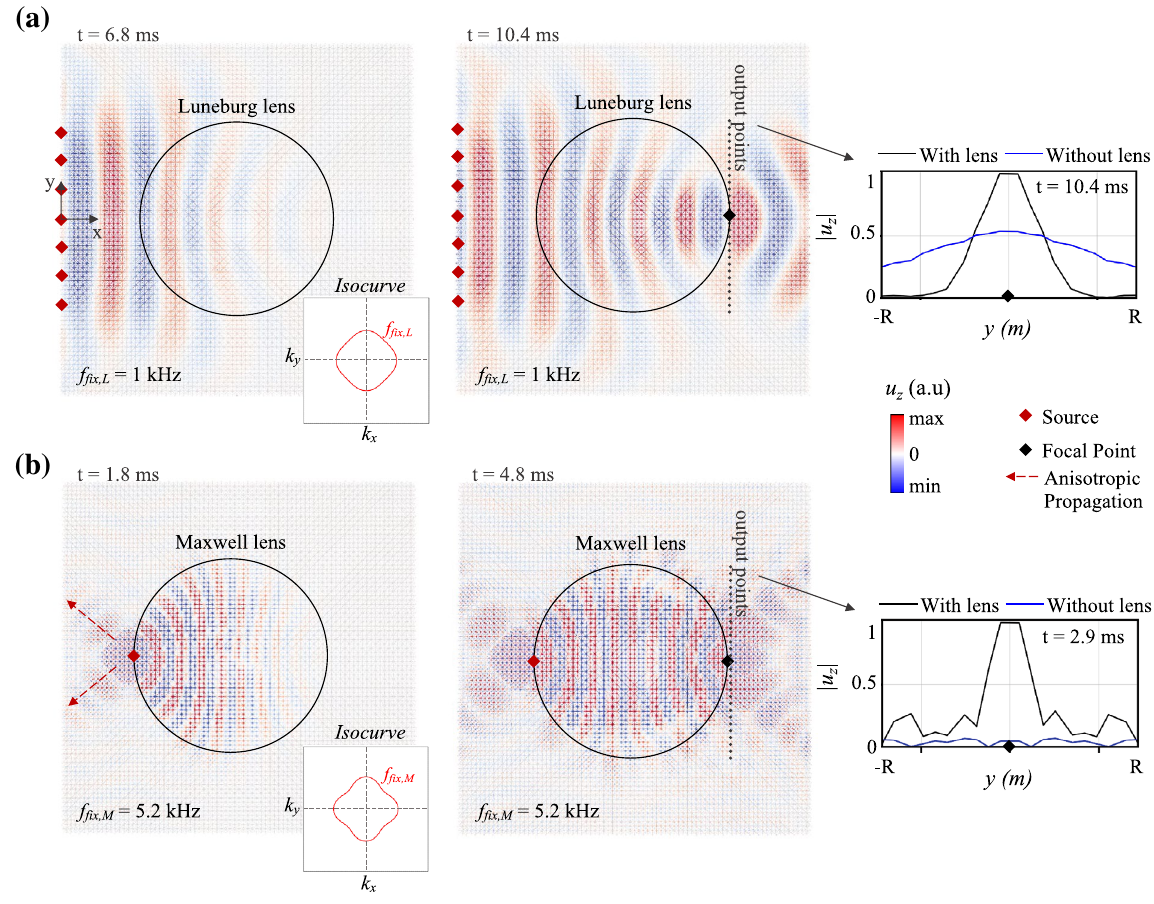
Figure 7. Wave field snapshots in gradient-index lenses consisting of octets with embedded masses. ( a ) Luneburg lens (black circle) with an impinging plane sinusoidal wave of frequency f fix , L at two consecutive instants. ( b ) Maxwell lens excited by a point source (red diamond) of frequency f fix , M at two instants. In both figures, the isofrequency contours of a standard octet-based plate within the first Brillouin zone at 1 and 5.2 kHz are depicted in the bottom right insets. The flexural displacement recorded by a line of receivers is compared to the equivalent field in a bare plate